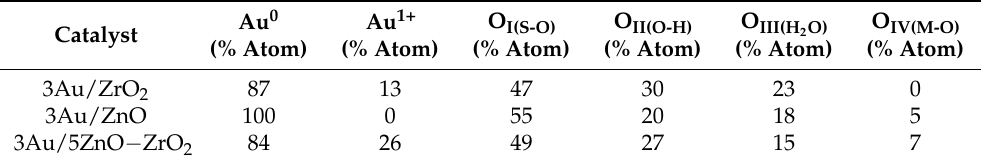
Figure 6. X-ray photoelectron spectra of the zinc Zn 2p, zirconium Zr 3d, oxygen O1s, and gold Au 4f deconvolution for the 3Au/ZrO 2 , 3Au/ZnO, and 3Au/5ZnO − ZrO 2 catalysts at 200 °C in air. Table 2. Deconvolution outcomes for O 1s and Au 4f species of the 3Au/ZrO 2 , 3Au/ZnO, and 3Au/5ZnO-ZrO 2 catalysts activated at 500 °C.